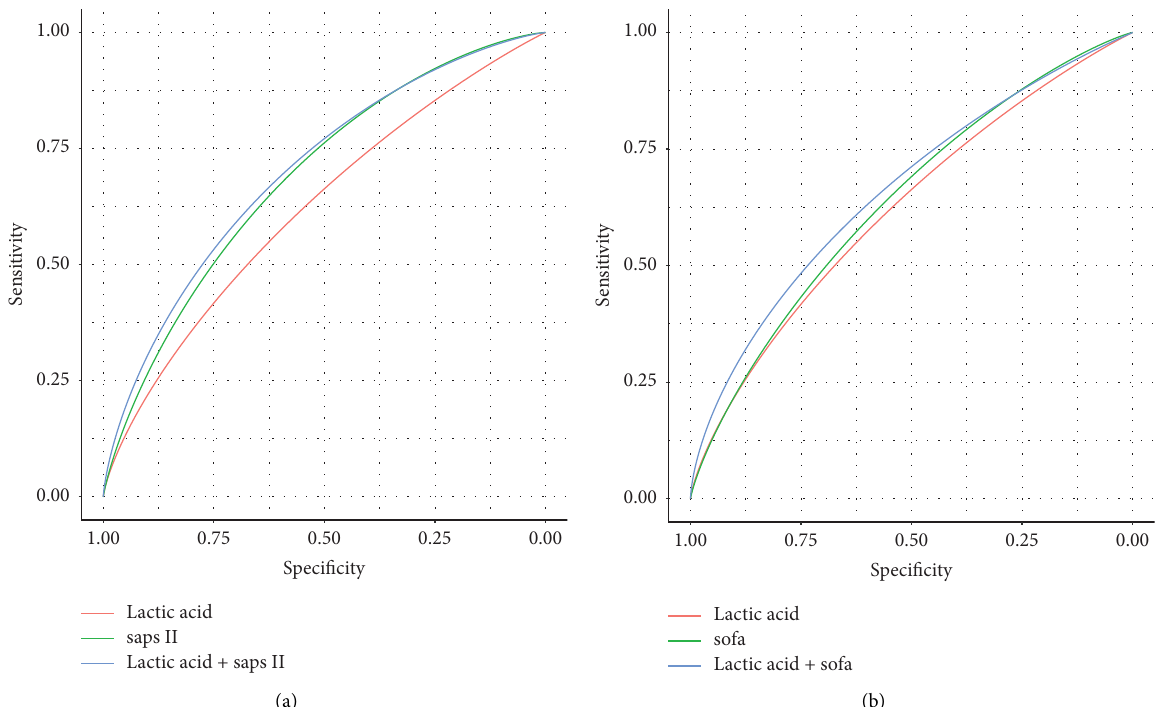
Figure 3: Receiver operating characteristic curve for predicting the risk of in-hospital all-cause death in patients with acute heart failure. (a), Te AUC of lactic acid � 0.616, with a sensitivity of 52.22% and a specifcity of 63.35%. Te AUC of SAPS II � 0.681, with a sensitivity of 67.75% and a specifcity of 57.80%. Te AUC of lactic acid combined with SAPS II � 0.696, with a sensitivity of 61.88% and a specifcity of 65.89%. (b). Te AUC of SOFA score � 0.646, with a sensitivity of 64.60% and a specifcity of 63.74%. Te AUC of lactic acid combined with SOFA score � 0.661, with a sensitivity of 76.37% and a specifcity of 48.13%. Note: Te x axis represents the false-positive rate, while the y axis shows the true-positive rate. Abbreviations: ROC, Receiver operating characteristic; AUC, the area under ROC curve; SAPS II, Simplifed acute physiology score II; and SOFA, Sequential organ failure